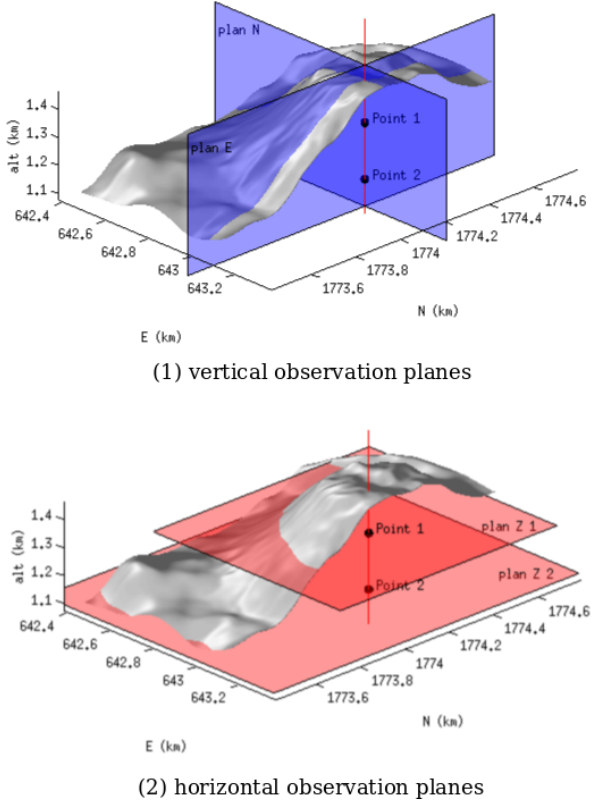
Figure 5. 3-D views of the cross sections used to represent the re- solving kernels in Figs. 6 and 7. The resolving kernels are computed at points 1 and 2. Point 1 is located at a level Z1 in the part of the lava dome scanned by the lines of sight of the muon telescope (Fig. 1.2) and point 2 is located at Z2 below the ray coverage of the